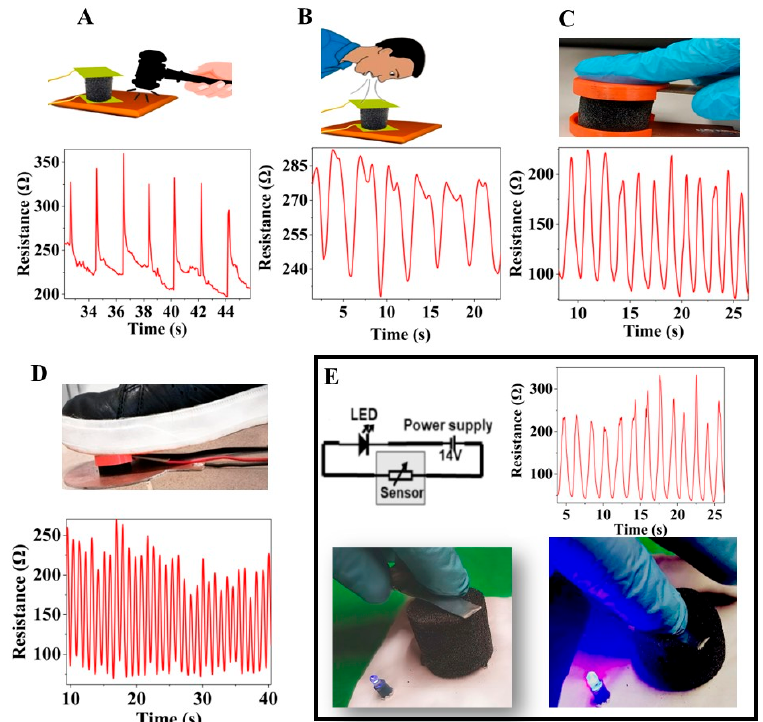
Figure 7. The developed N-BCNT/PU (sample 1) pressure sensor were tested in vibration detection ( A ), breath detection ( B ), finger touch detection ( C ), motion detection ( D ), and a LED-containing pressure sensor circuit was successfully created ( E ).